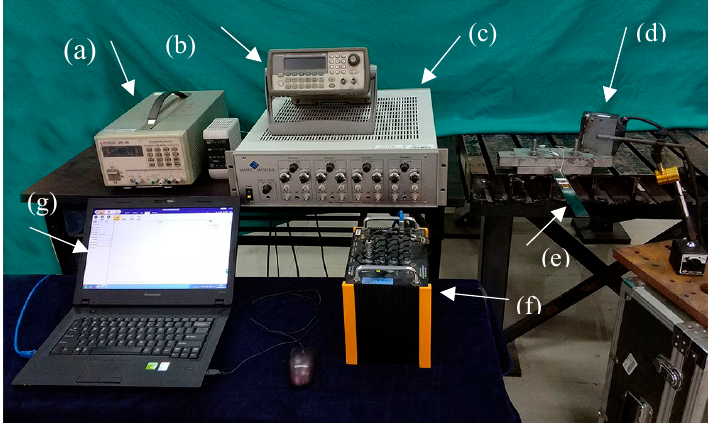
Figure 4 . Actuation function test set up for the MFC actuator: (a) DC power; (b) Signal generator; (c) Figure 4. Actuation function test set up for the MFC actuator: ( a ) DC power; ( b ) Signal generator; High voltage amplifier; (d) Laser sensor; (e) Steel beam with MFC; (f) Signal acquisition system (g) ( c ) High voltage amplifier; ( d ) Laser sensor; ( e ) Steel beam with MFC; ( f ) Signal acquisition system PC. ( g ) PC.